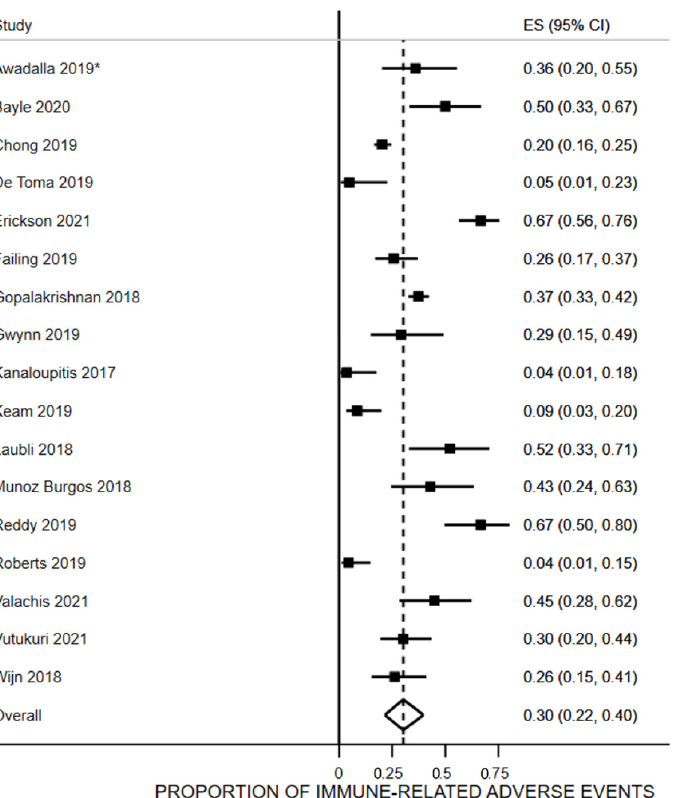
Figure 2. Proportion of patients receiving immune checkpoint inhibitors who were vaccinated and reported an immune-related adverse event. * Awadalla et al., 2019 reported rates of any type of irAEs in patients who already had myocarditis due to the immune checkpoint